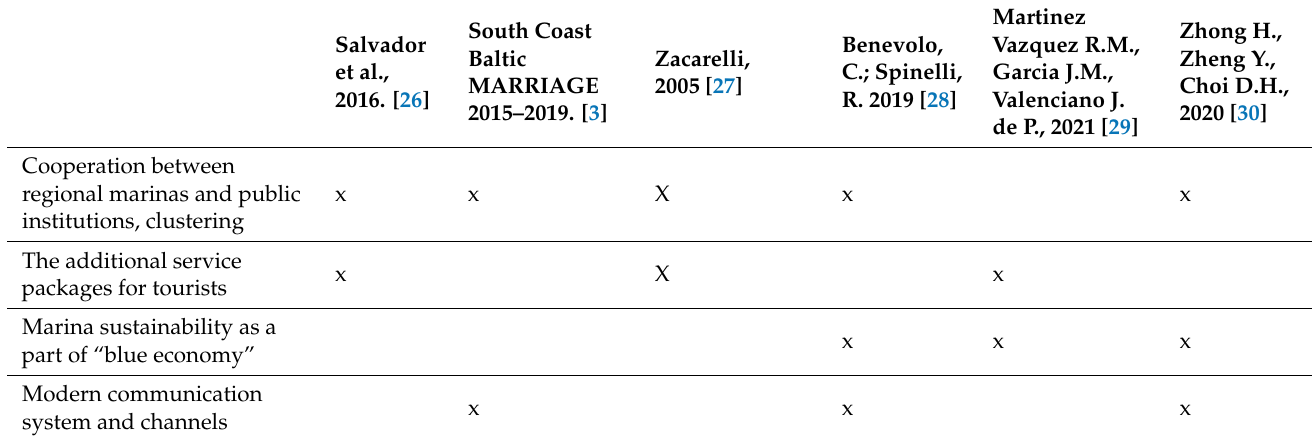
Table 2. Trends of sustainable marina